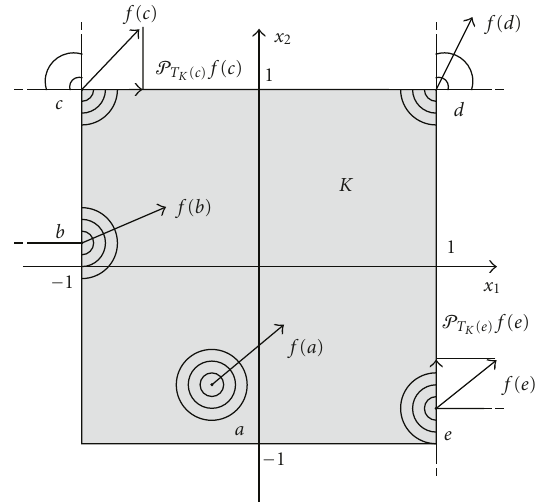
Figure 3: Vector fields involved in the definition of the derivative Dφ for a second-order FR-CNN. Let f ( x ) = A x + I . We have ( x ), hence Dφ ( x ) is a singleton, when x is one of P T f ( x ) ∈ N ⊥ K K ( x ) the points a , d , e ∈ K . On the other hand, P T then Dφ ( x ) = ∅ , when x is one of the points b , c ∈ K